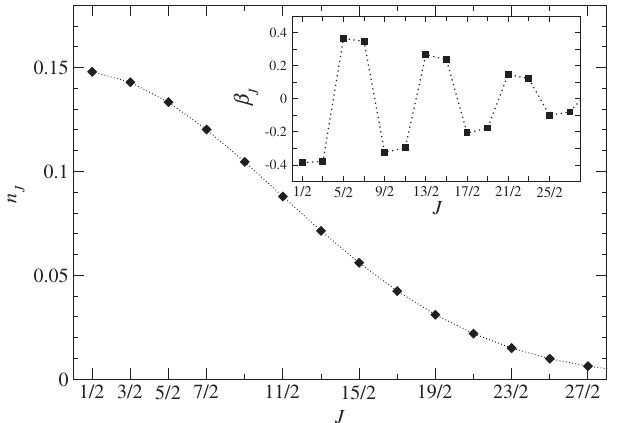
FIG. 4. Distribution function n J ¼ j β J j 2 vs J for the N ¼ 2 ground state of H ∞ . We here take λα 2 ¼ 10 4 , which leads to E ≃ − 0 . 099 272 5 . We stress that both β min as well as n J are independent of the total angular momentum M 2 M ℏ . Dotted lines serve only as guides to the eye. s ¼